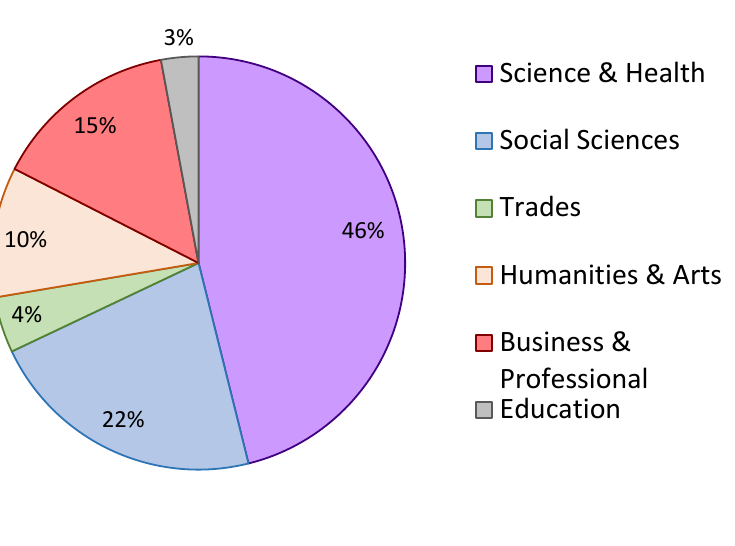
Figure 1. Open textbook adoptions by discipline.